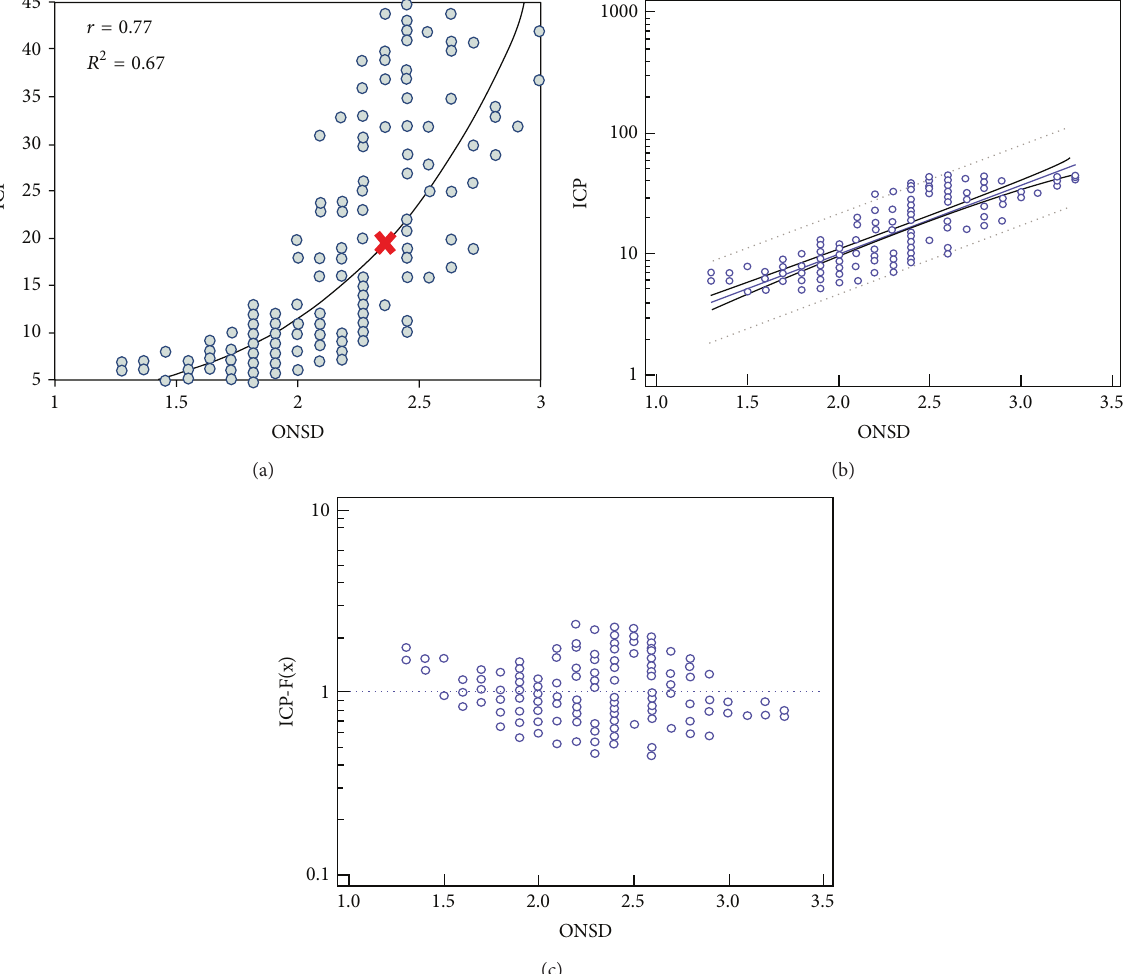
Figure 7: (a) Optic nerve sheath diameter (ONSD) in mm plotted versus the ICP (mmHg); the scatter plot displays a positive exponential relation (slightly different compared to the PI plot) between the two parameters rather than an exact linear relation. (b) Regression analysis model: the “dots” represent the actual measured values, while the blue line in the middle represents the estimated values by the model and the dashed lines represent 95% confidence intervals. (c) Goodness of fit for the model-driven prediction equation calculating the proximity of the predicted values (dots) to the actual measured values (dashed blue